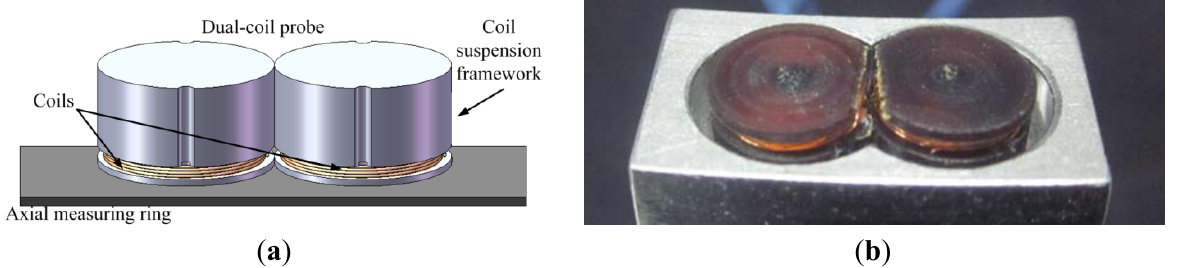
Figure 5. The sketch of the dual-coil ECDS. ( a ) Diagrammatic sketch of the dual-coil probe and the measuring ring; ( b ) Photo of the dual-coil